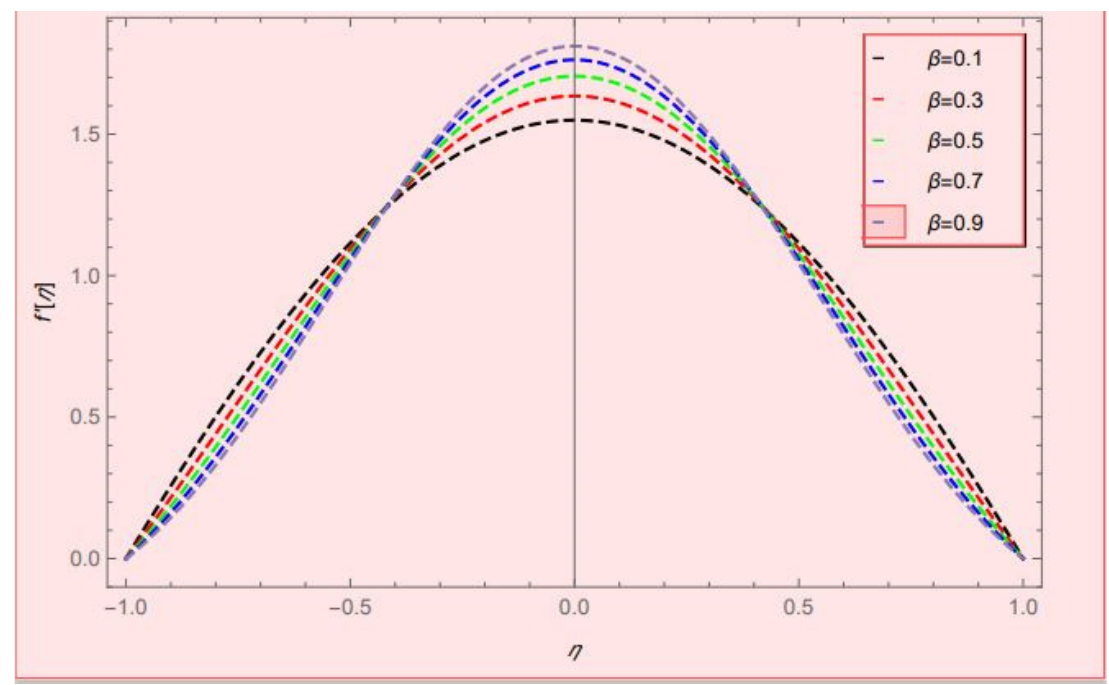
Figure 10. Velocity profile effect against the Casson fluid parameter ( 𝛃 ) for 𝛼 = 2, 𝑃𝑟 = 0.1, 𝑁𝑡 = 𝑁𝑏 = 0.7,𝑅𝑒 = −2.5, 𝑀 = 12,𝐵𝑟 = 0.1,𝜑 (cid:2869) = 𝜑 (cid:2870) = 0.02, ℎ = 2, 𝑟 = 1.5.